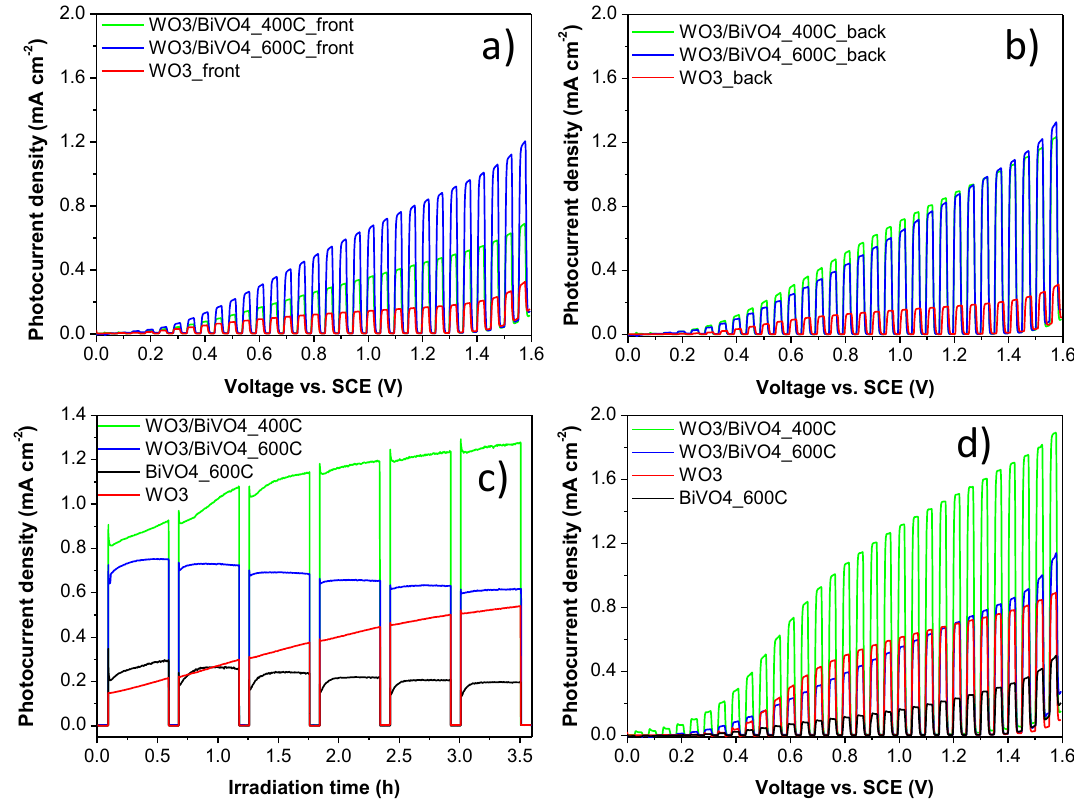
Figure 5. Effect of the post calcination temperature (400 or 600 °C) on the photoelectrochemical (PEC) performance of the WO 3 / BiVO 4 heterojunctions: Chopped Linear Sweep Voltammetry (LSV) curves under ( a ) front and ( b ) back irradiation of as-prepared samples; ( c ) chronoamperometry (CA) stability tests at 1.0 V vs. SCE; ( d ) chopped LSV curves under back irradiation recorded after CA tests (panel c ). The WO 3 and BiVO 4 film thicknesses were 1000 and 200 nm, respectively. All measurements were